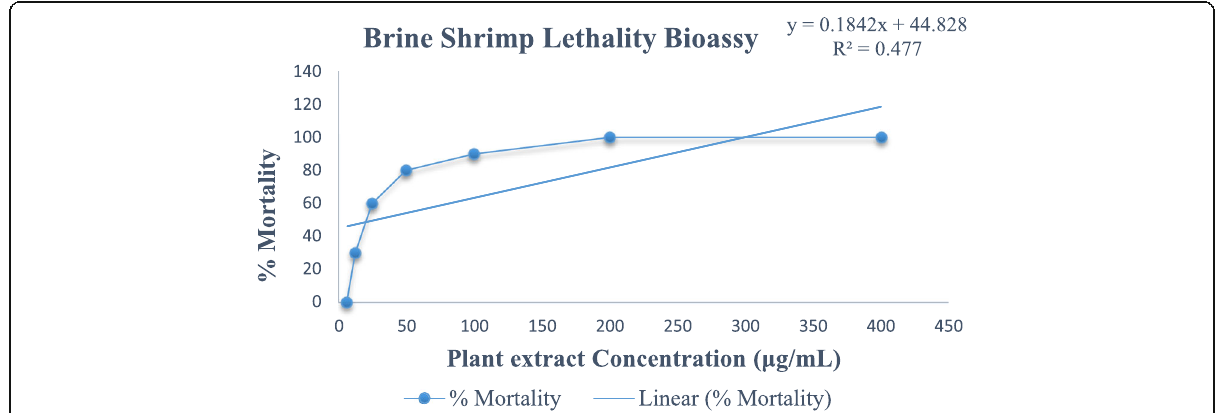
Fig. 7 Brine shrimp lethality bioassay of Chenopodium album leaf